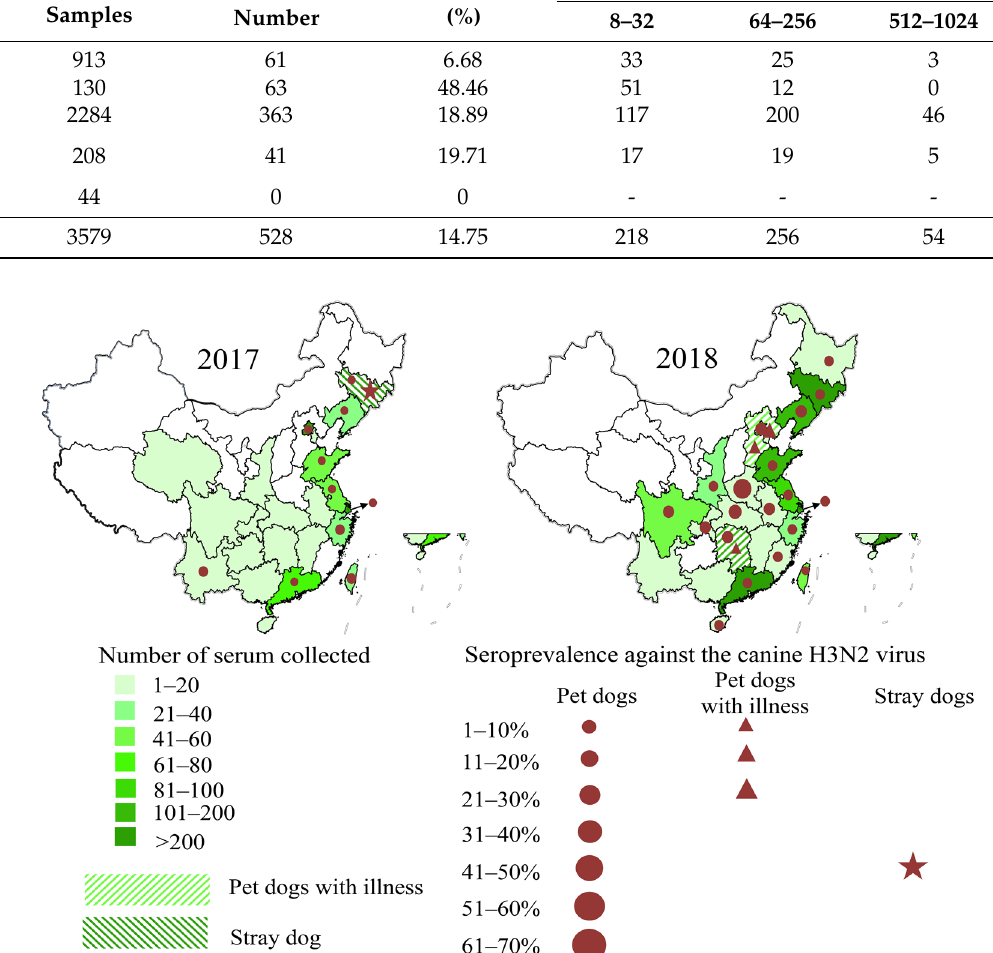
Figure 2. Prevalence rates of H3N2 CIVs in dogs across China in 2017–2018. ( a ) Prevalence rates of H3N2 CIVs in dogs across China in 2017. ( b ) Prevalence rates of H3N2 CIVs in dogs across China in 2018. Provinces with sampling points are marked green, and the sampling quantity is reflected by the color depth. Red dots, samples from pet dogs; red triangle and stars, samples from pet dogs with illness and stray dogs, respectively. The symbol size was used to describe the size of seroprevalence.